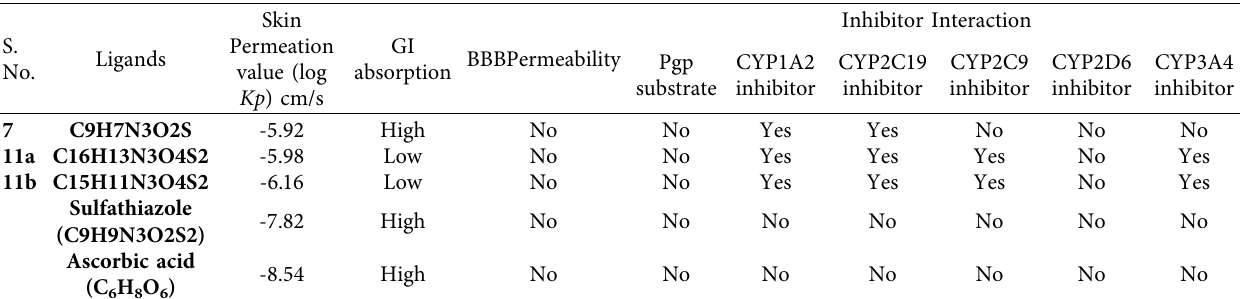
Table 6: ADME predictions of compounds, computed by SwissADME and PreADMET.